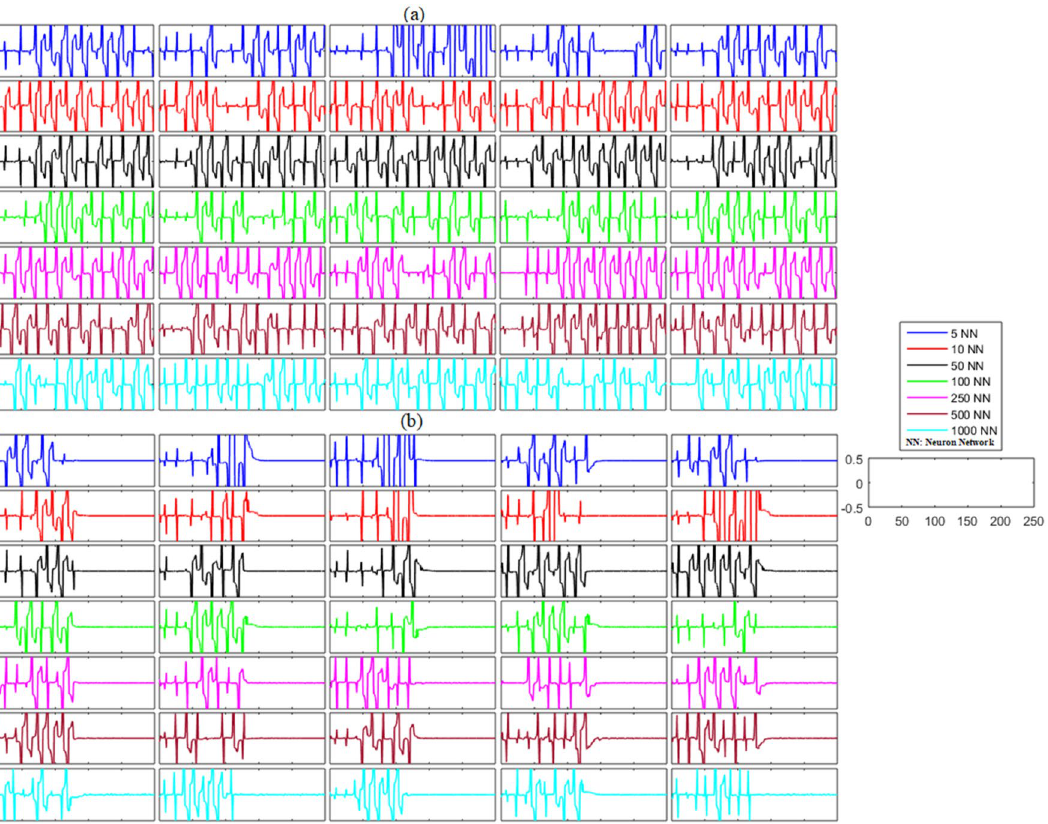
Figure 4. ( a ) Without control synchronization dynamics of the membrane potential states (x-states) of different time-delayed unidirectional FHN networks with noise. ( b ) Controlled synchronized error dynamics of the membrane potential states (x-state) of different time-delayed unidirectional FHN networks with states. Contrastingly, both states of the networks achieved zero error after the application of the proposed control scheme at t = 130, as shown in Figs. 6b and 7b. The mean errors for both states of each network are listed in Table 4. These results suggest that each state of the delayed neuronal network achieved synchronized behavior with the state of the corresponding slave neuron because the outcome of the time dynamics of error converged to zero.